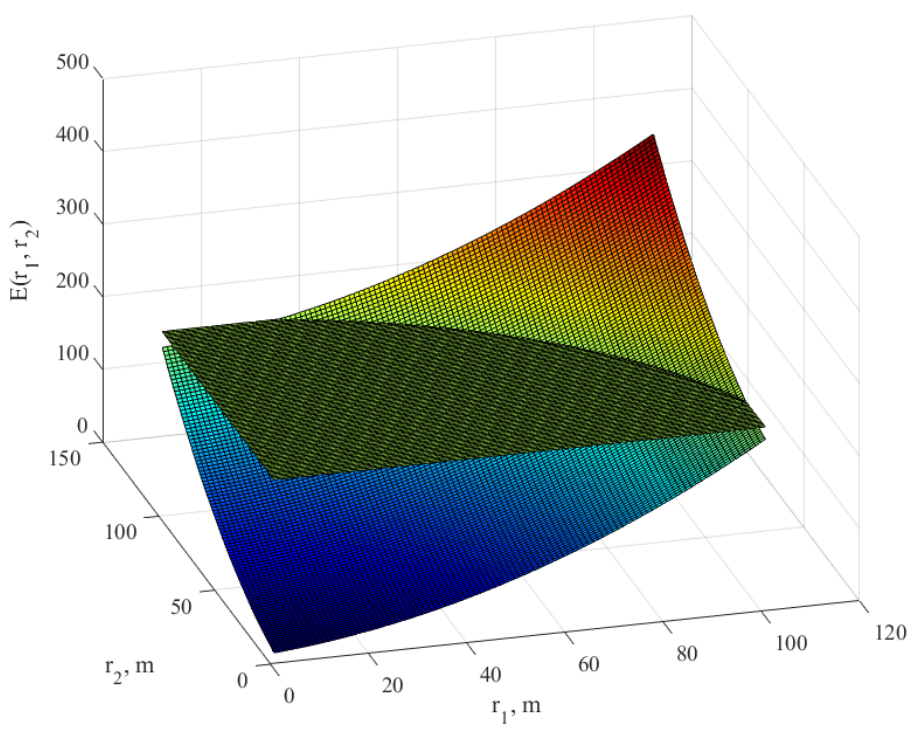
Figure 5. Energy consumption function E ( r 1 , r 2 ) for values r 1 ∈ [ 3, 15 ] , r 2 ∈ [ 2, 15 ] and the plane E = 250.